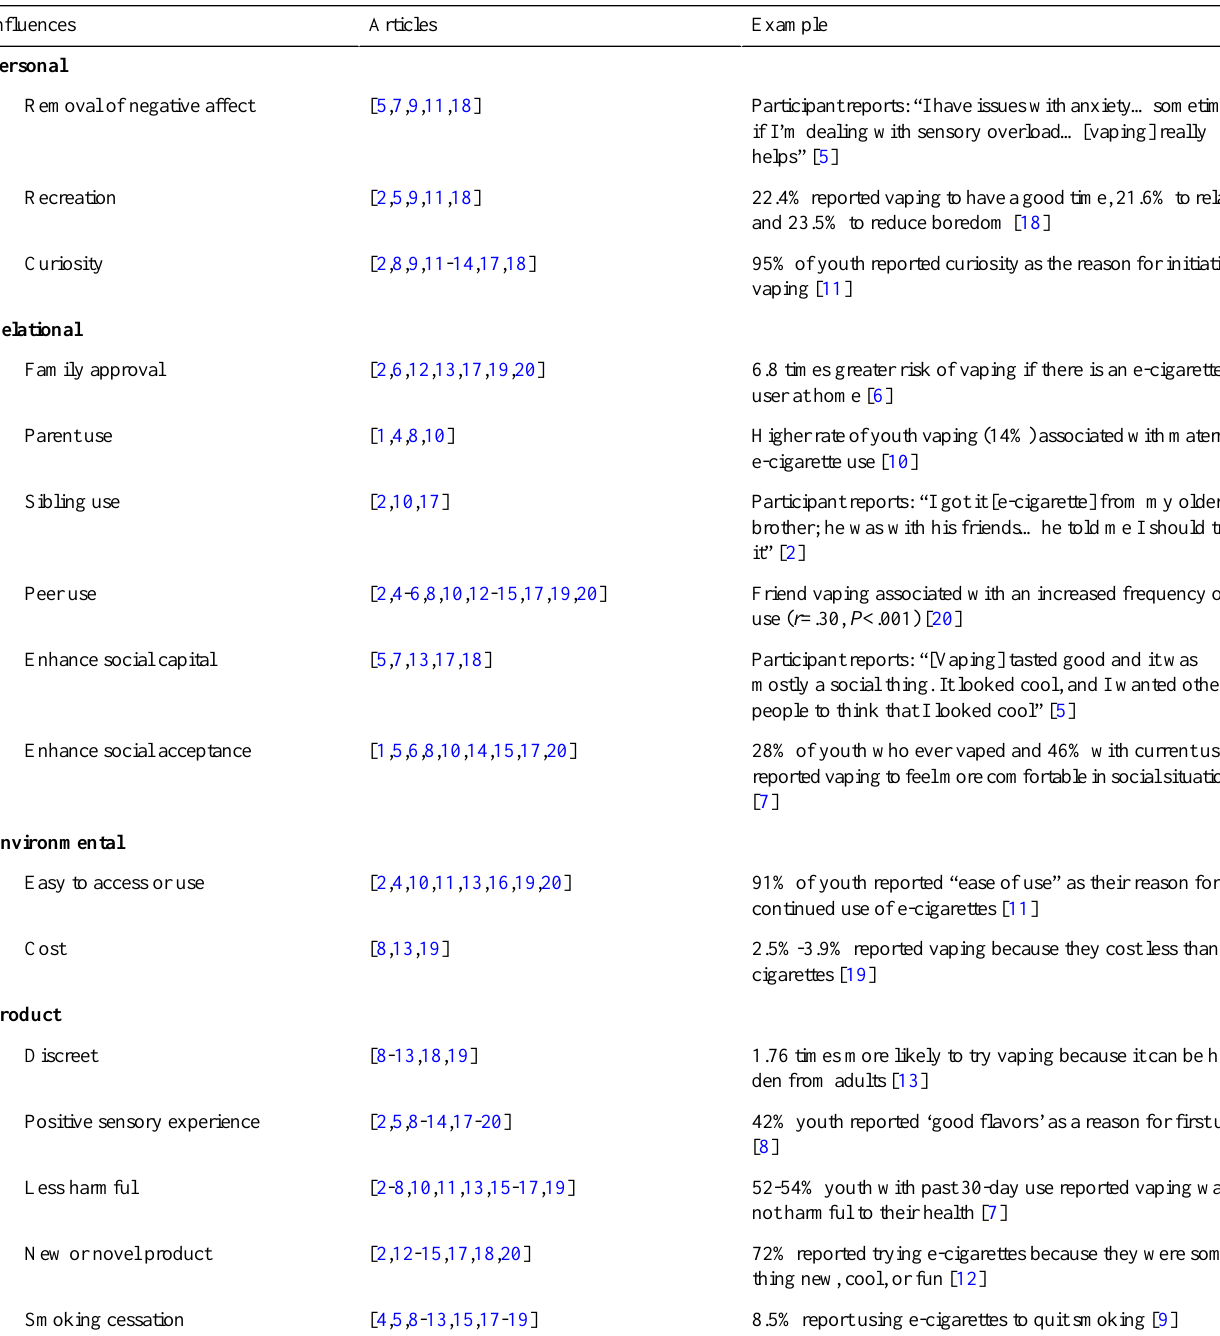
Table 1. Influences on youth electronic cigarette (e-cigarette) uptake. See Multimedia Appendix 2 for the reference list.